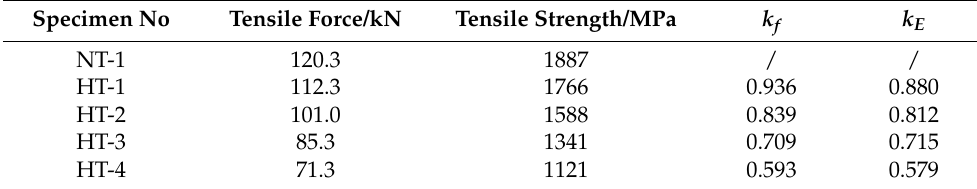
Table 2. Tensile test results of each